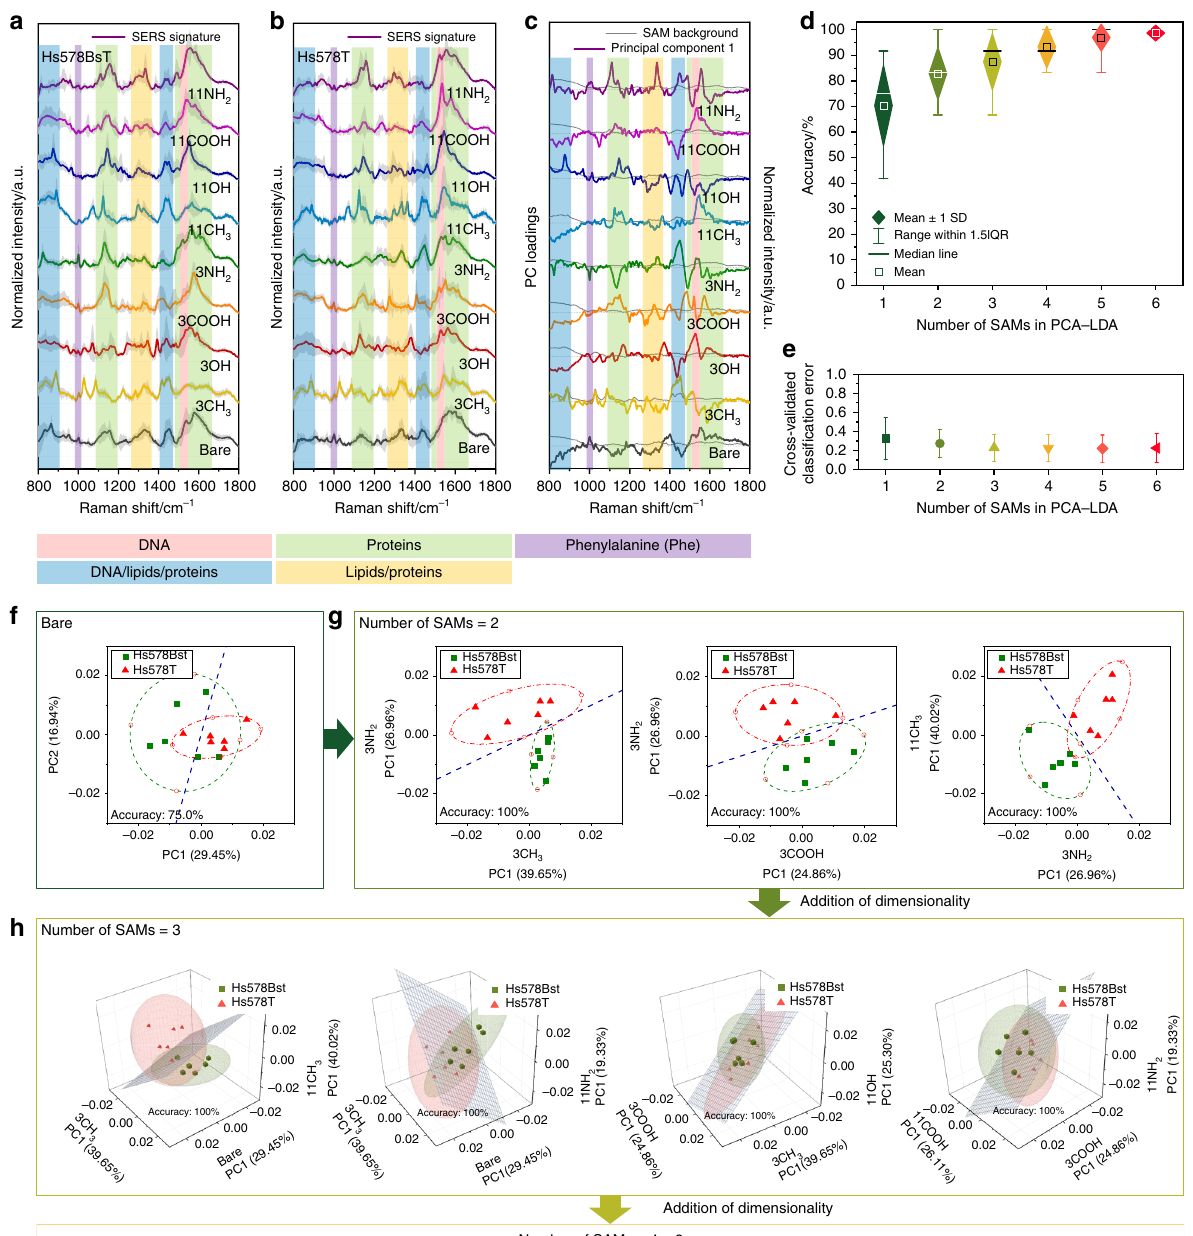
Fig. 5 Arti fi cial-nose-empowered statistical multivariate analysis of model biological systems. a , b Series of SERS spectra from cell lysates obtained from functionalized Au-nanopillars with various SAM-forming molecules: non-functionalized (bare), 1-propanethiol (3CH 3 ), 3-mercapto-1-propanol (3OH), 3-mercaptopropionic acid (3COOH), 3-amino-1-propanethiol (3NH 2 ), 1-undecanethiol (11CH 3 ), 11-mercapto-1-undecanol (11OH), 11-mercaptoundecanoic acid (11COOH), 11-amino-1-undecanethiol (11NH 2 ). a Hs578Bst normal fi broblast-like cells, and b Hs578T breast carcinoma cells. Solid lines and grey shaded area represent mean and± 1 s.d. of six obtained spectra ( N = 3, n = 2 spectra). Coloured shaded bands refer to tentative assignments established in the literature 58 – 62 . c – h Principal component analysis (PCA) – linear discriminant analysis (LDA) for the two cell lysates: c First principal component (PC1) loadings of SERS spectra from each functionalization. Overlapped grey lines indicate the background SERS signatures of the substrates in PBS (10 mM, pH 7.4). d Mean accuracy for discrimination of cancerous cell lysates (Hs578T) from non-cancerous cell lysates (Hs578Bst) using PCA – LDA models, calculated at each dimensionality from all possible cross-combinations of the nine PC1s. e Evaluation of predictive performance of the PCA – LDA models in ( d ) using leave-one-out cross-validation (LOOCV). CV-classi fi cation errors represent the misclassi fi ed fraction of the observations for each LOOCV model. Data represent mean ± 1 s.d. of all the models at each dimensionality. f Scatter plot of the fi rst principal component (PC1) versus the second principal component (PC2) from non-functionalized Au-nanopillars. g Representative two-dimensional PCA scatter plots for the two cell lysates using PC1s of two different SAM functionalization. Blue dotted line was derived by LDA as a classi fi cation algorithm to separate the two groups. Red and green dotted boundaries represent con fi dence intervals of the ± 1 s.d. of each group. Inset is the calculated accuracy in cancerous cell lysates (Hs578T) discrimination for each model. h Representative three-dimensional PCA scatter plots with each axis corresponding to the PC1s of three different SAM-functionalized Au- nanopillars. Blue planes depict classi fi cation derived from LDA algorithm separating the two groups. Red and green ellipsoids represent ± 1 s.d. of each